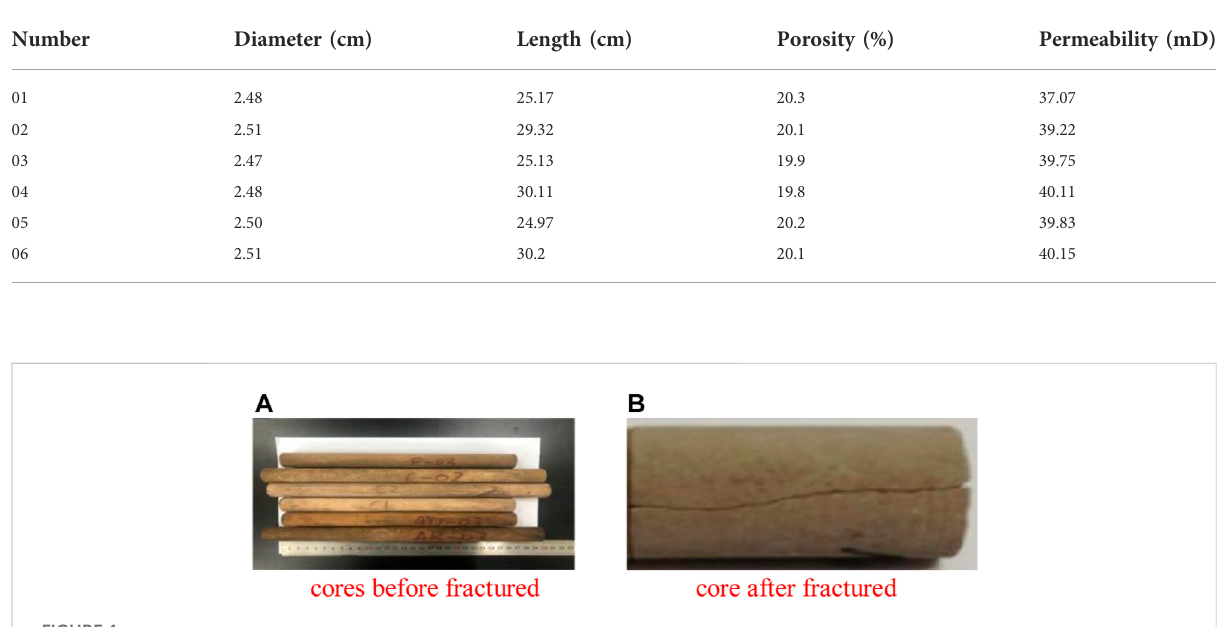
TABLE 1 Parameters of